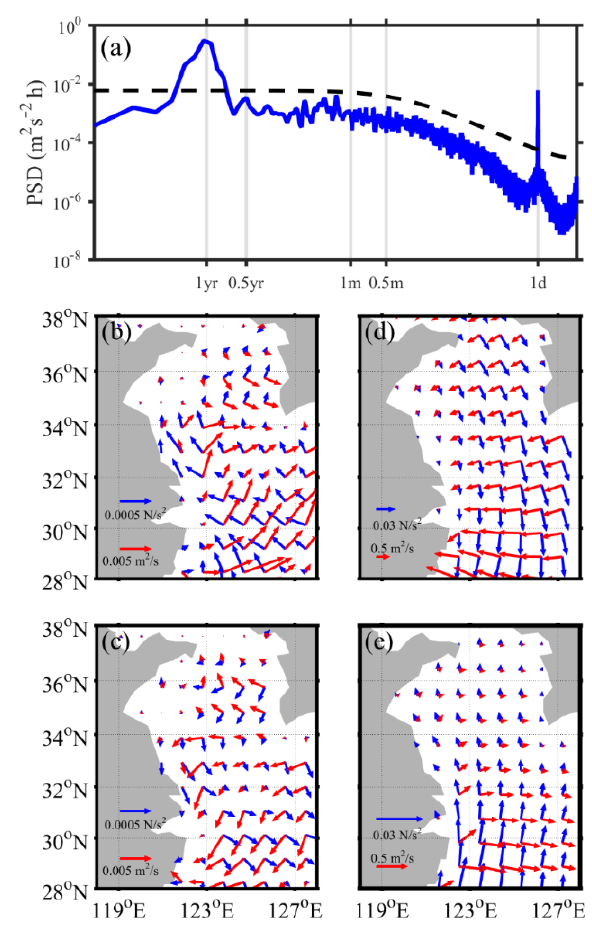
Figure 11. ( a ) The power spectrum of the domain-averaged wind velocity (dashed line denotes the 95% confidence level). The spatial distributions of climatological wind stress (blue vectors) and induced Ekman transports (red vectors) in ( b ) daytime, ( c ) nighttime, ( d ) winter, and ( e ) summer are shown as well.